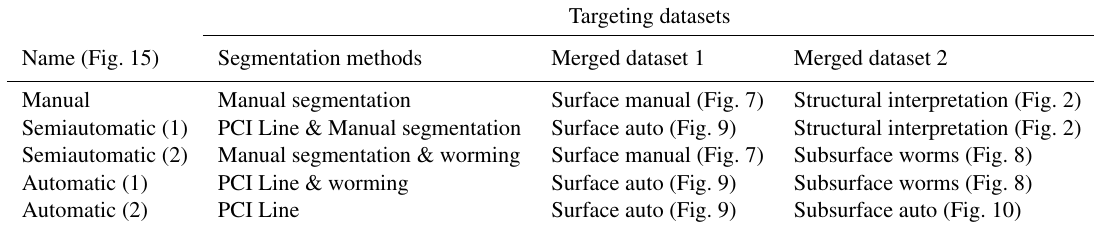
Table 2. Summary of the targeting datasets (Figs. 12, 13, and 14) and name convention used in the combined targeting map (Fig.